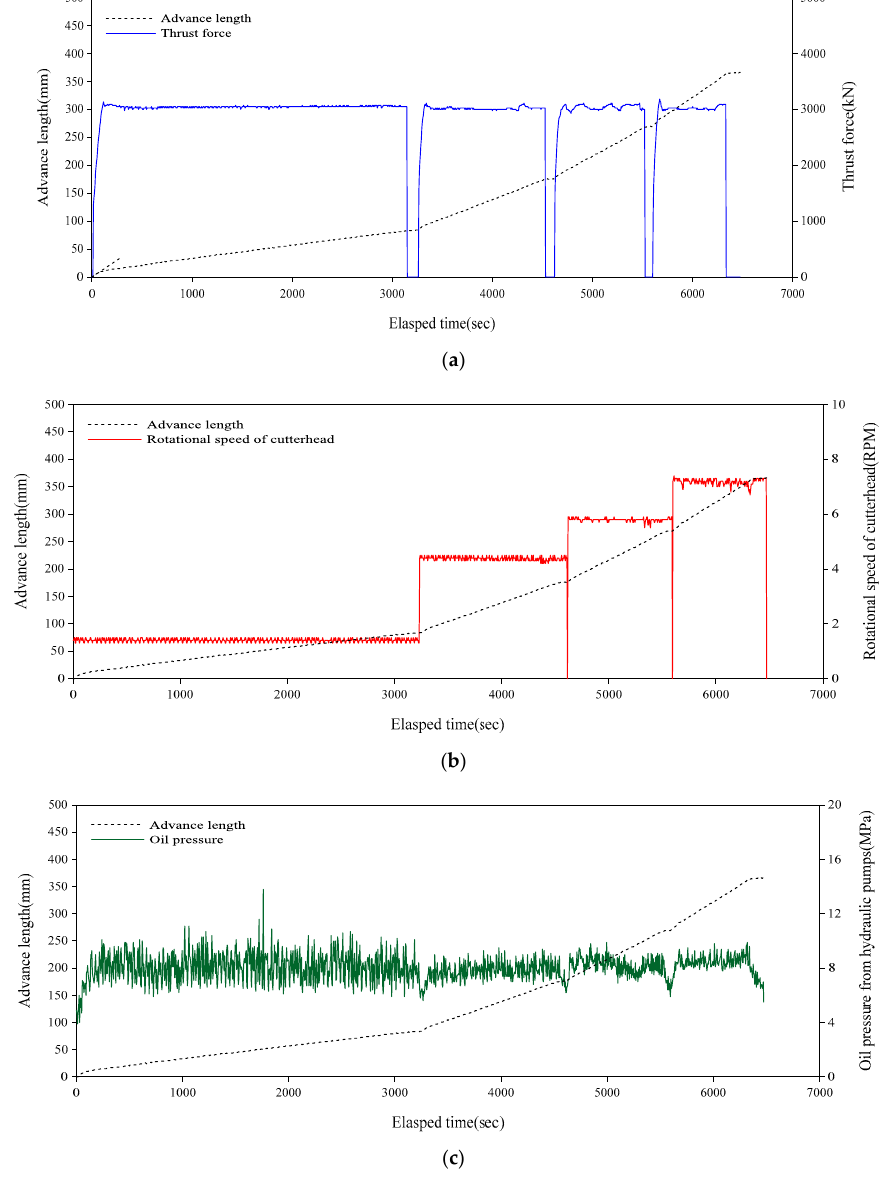
Figure 6. Machine data profiles developed with respect to TBM advancement, ( a ) advance length and thrust force; ( b ) rotational speed of cutterhead; ( c ) oil pressure from the pumps .